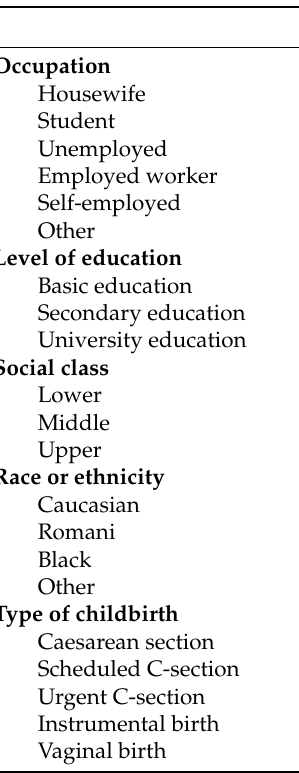
Table 1. Sociodemographic and descriptive characteristics of participants ( n = 6060).